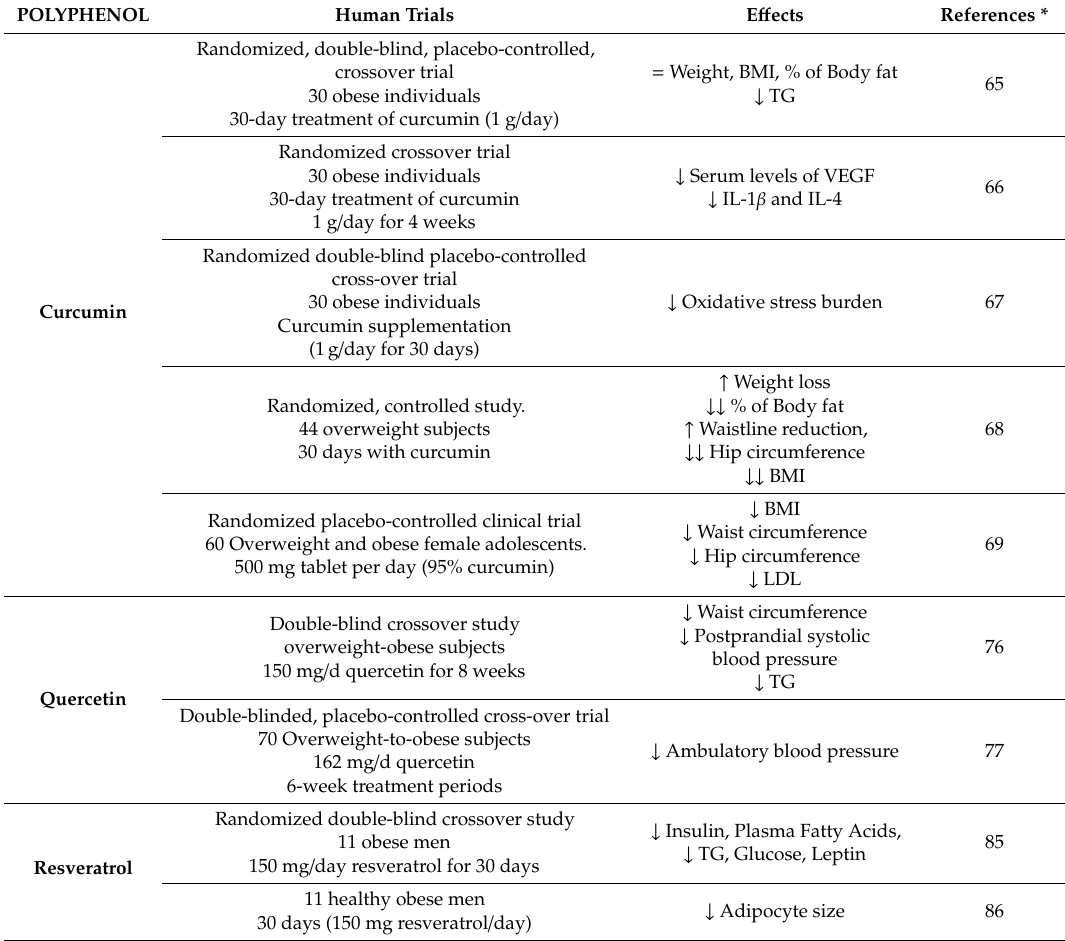
Table 1. Anti-obesity actions of curcumin, quercetin, and resveratrol.